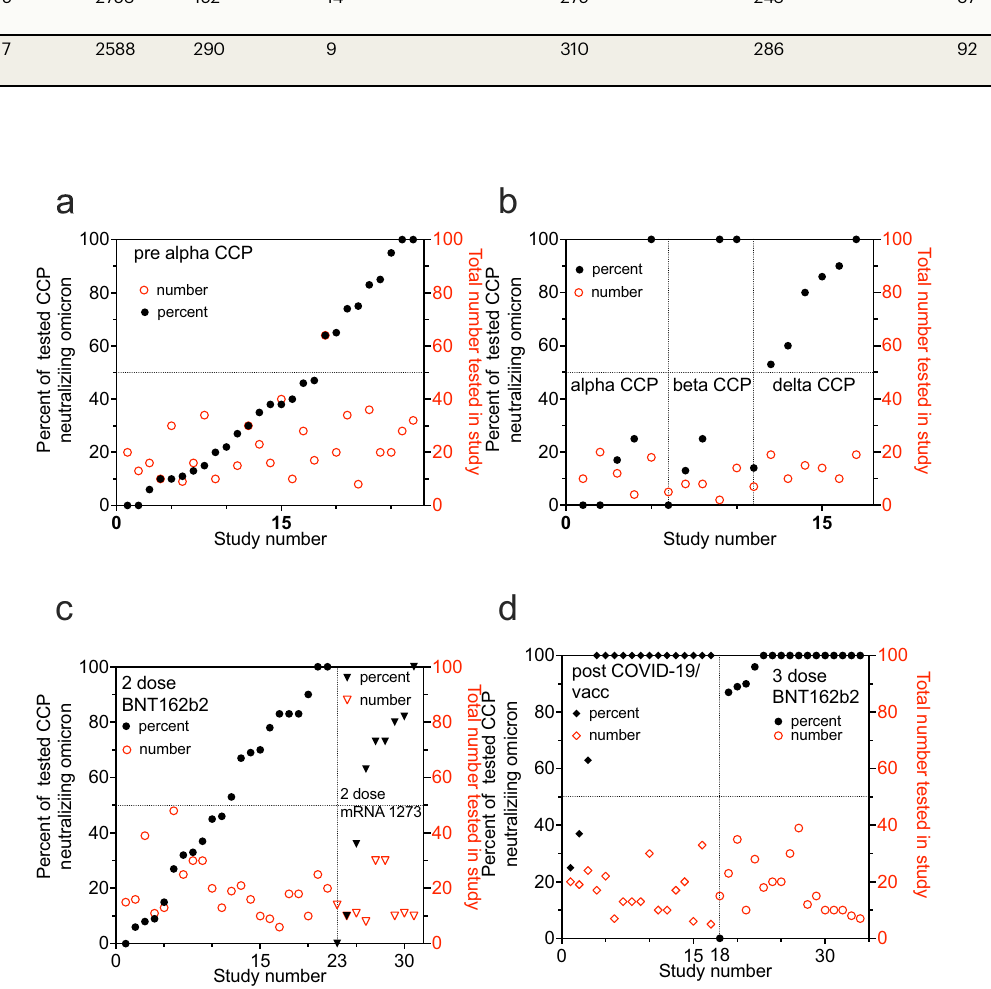
Fig.3|Percentofindividualplasmasamplesineachstudyshowinganytiterof Omicron BA.1 neutralization. The percent of total samples within a study which neutralized Omicron BA.1 graphedin increasing percentages on left y axiswith the totalnumberofsamplestestedontheright y axis. a pre-AlphaCCPneutralizationof